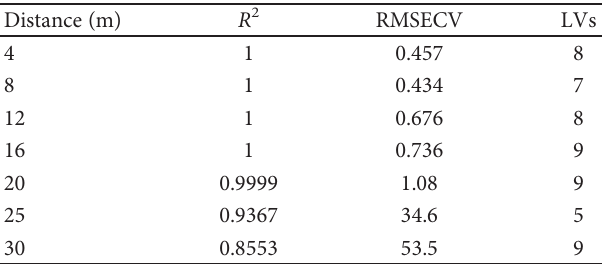
Table 2: PLS calibration parameters for various angles of collection